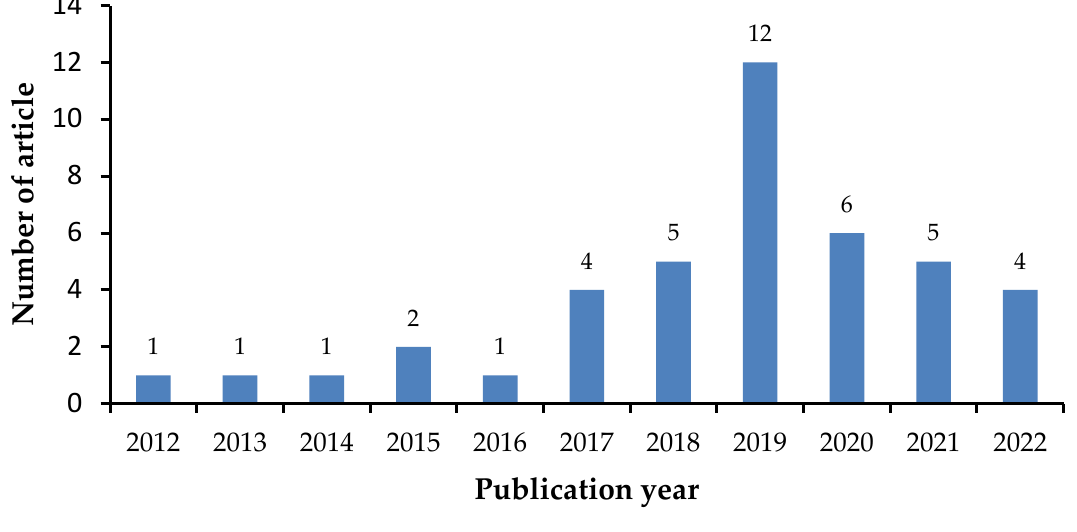
Figure 3. Number of articles per year.